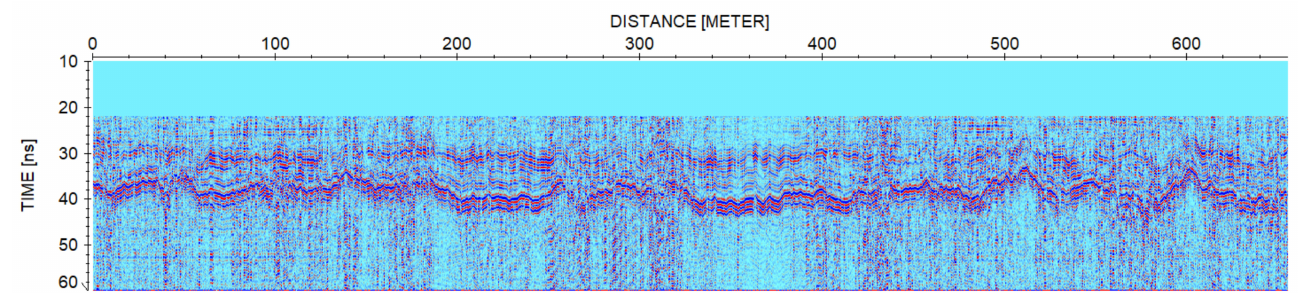
Figure 11. Section of the entire Gressoney survey (after the post-processing described in the Methods section, not corrected for the flight altitude). The accuracy in the detection of the air–snow interface is very poor in some parts, e.g., at 250–300 m of relative coordinates, and at 420–480 m.